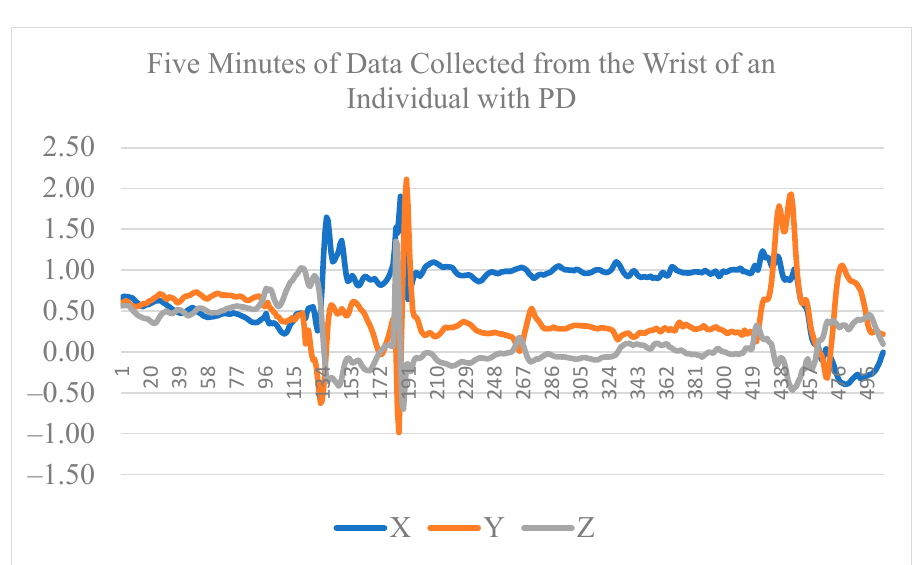
Figure 3. First five minutes of raw data collected from the wrist of an individual with PD.